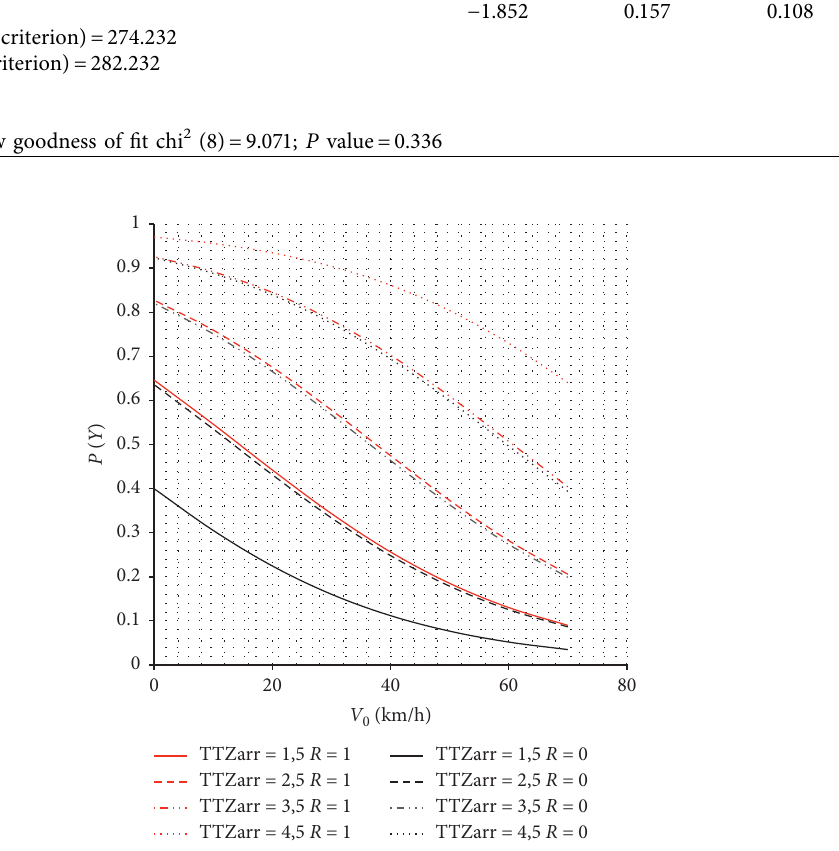
Figure 6: Effects of variables V 0 , TTZ arr , and pedestrian crossing configuration R on likelihood to yield ( P ( Y